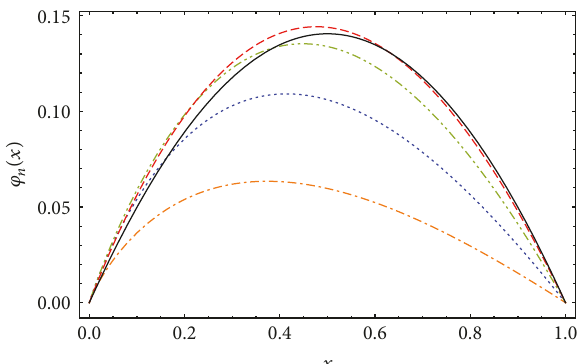
Figure 1: 𝜑 𝑛 (𝑥) when 𝑛 = 10 obtained by the Duan-Rach modified ADM for 𝛼 = 1.2 (dot-dash), 𝛼 = 1.4 (dot line), 𝛼 = 1.6 (dot-dot- dash), 𝛼 = 1.8 (dash line), and 𝛼 = 2 (solid